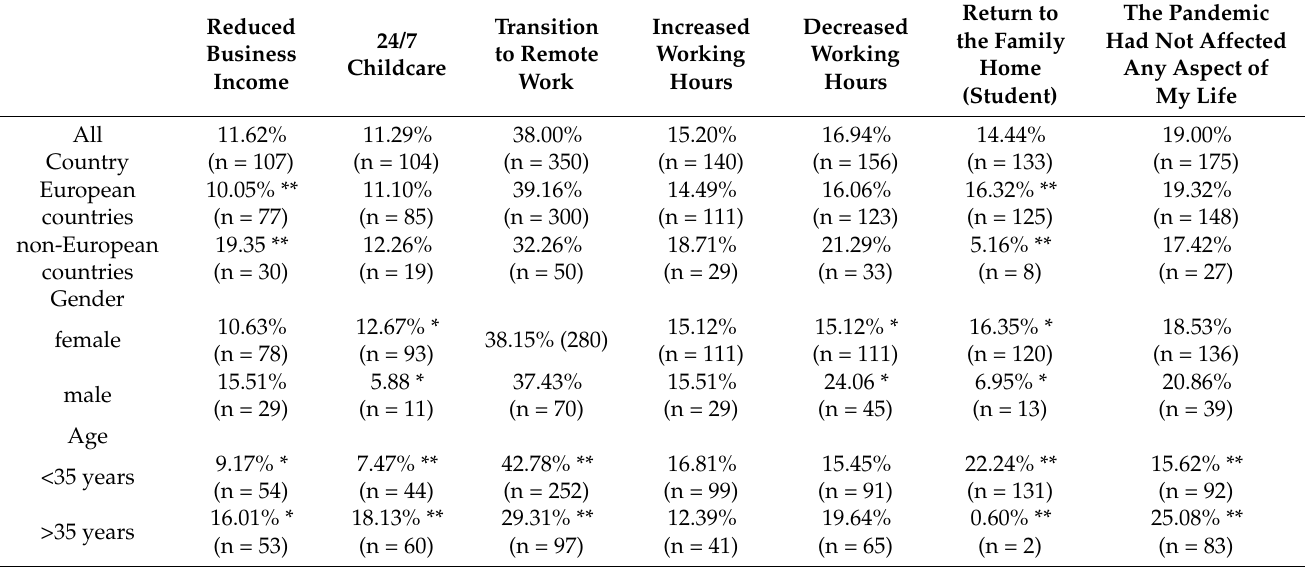
Table 2. Change in life situation acc. to country, gender, and